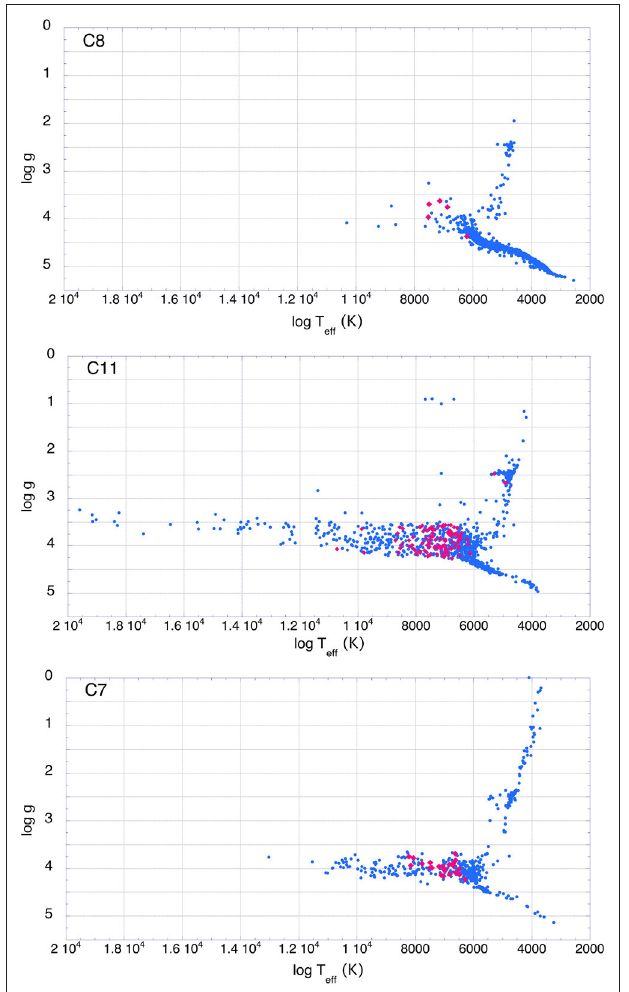
FIGURE 2 | T eff distribution of C8, C11, and C7 targets observed by K2. Sct candidates varied from 4% (C11) or 5% (C7) down to only 0.15%